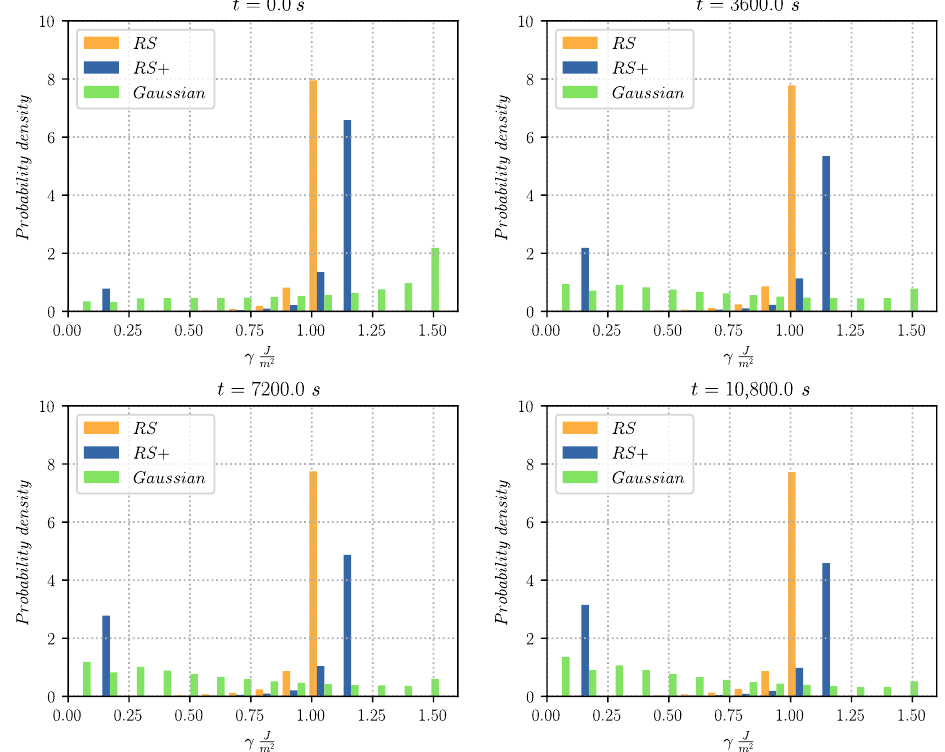
Figure 11. Normalised grain boundary energy distribution using various functions for the compu- tation of the GB energy γ . The distributions are given for every hour of thermal treatment. Each class of data contains the results of four different initial states representative of the same initial grain size